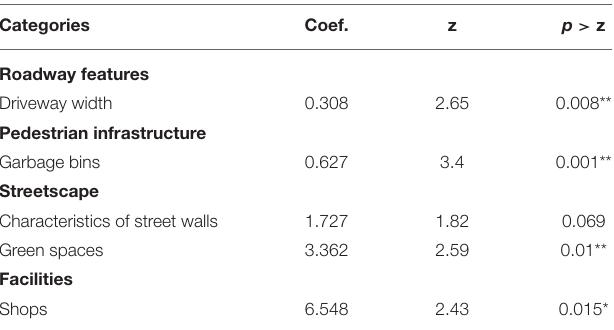
TABLE 3 | Conditional logit results of chosen and the least directional changed route (the entire route between OD